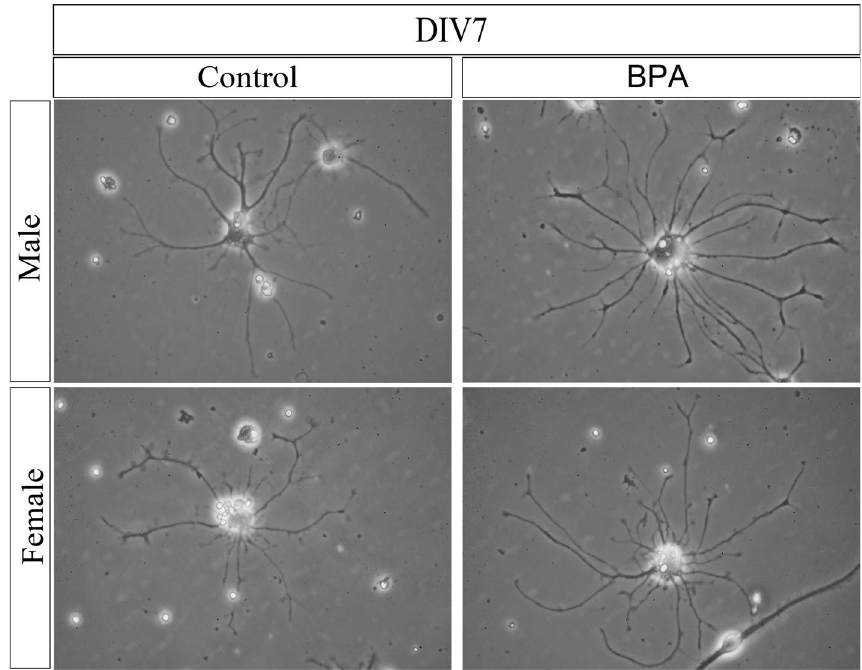
Figure 5. Representative images of primary hippocampal cells prenatally exposed to BPA or vehicle control. Primary hippocampal cells were isolated from male and female rat pups prenatally exposed to BPA or the vehicle control and cultured for 7 days. Images of the cells were taken using an inverted